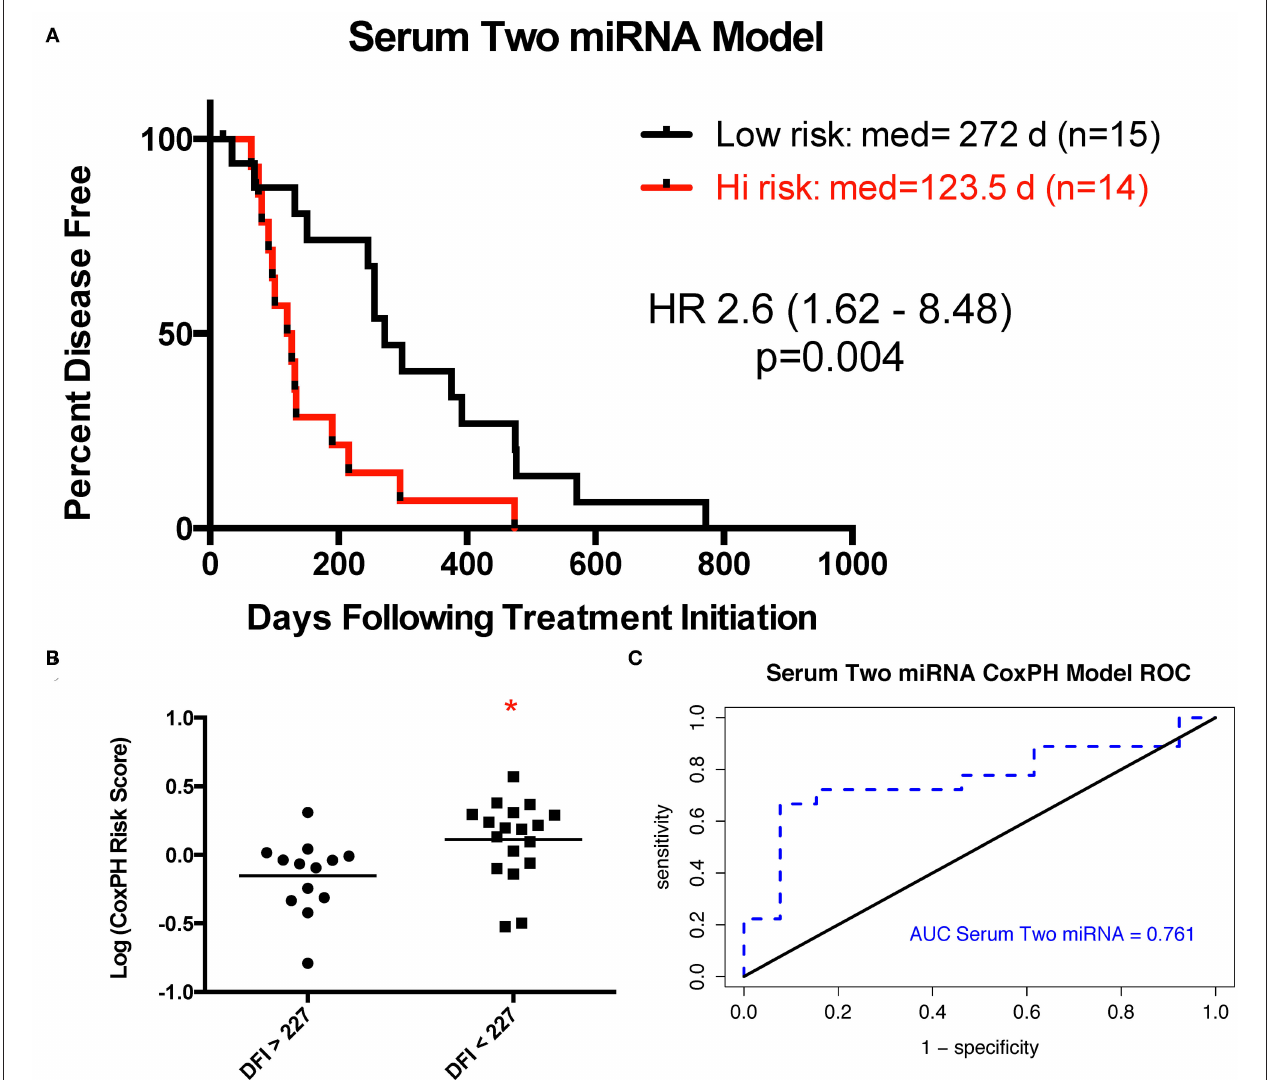
FIGURE 4 | Two-miRNA serum-based predictive model. (A) Kaplan–Meier survival curve with log rank test (cutoff is median risk score: 1.0372). (B) Scatter plot of risk scores in two outcome groups based on mean disease-free interval (DFI) for all 33 samples (* p = 0.014, Mann–Whitney test). (C) Receiver operator characteristic curve for serum two-miRNA Cox proportional hazard-based risk score dividing outcome groups based on mean